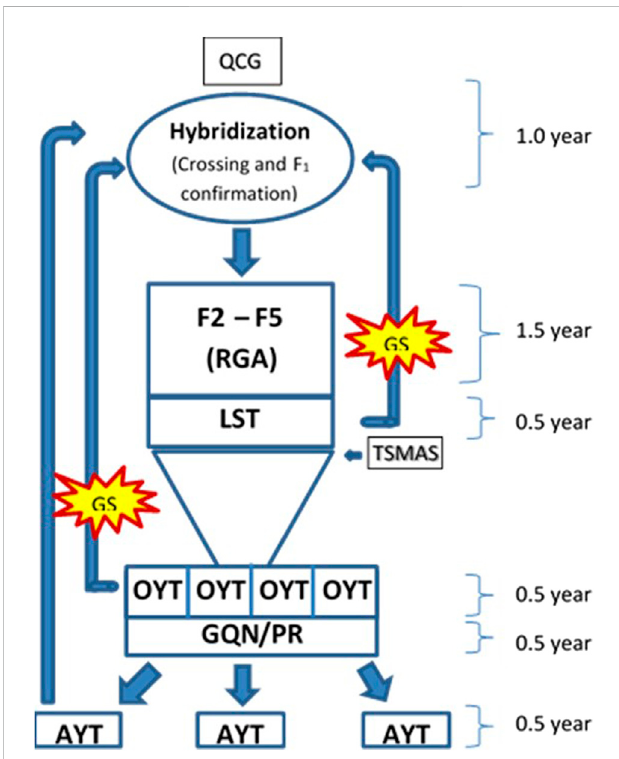
FIGURE 7 Schematic diagram of core part of breeding pipeline of irrigated rice breeding program for favorable ecosystem showing a breeding cycle of 4.5 years. QCG, Quality control genotyping used for parental puri fi cation and hybridity test of crosses. LST, line stage testing, is usedforgenotypingwithtraitspeci fi cmarkersandseedmultiplicationof the selected entries. OYT, observational yield trial, is the initial multi- location yield trial, AYT, advanced yield trial, is performed at multi- location with the selected entries from OYT. GQN, grain quality and nutrition, and PR, pest reaction of the OYT lines are checked before promotion to